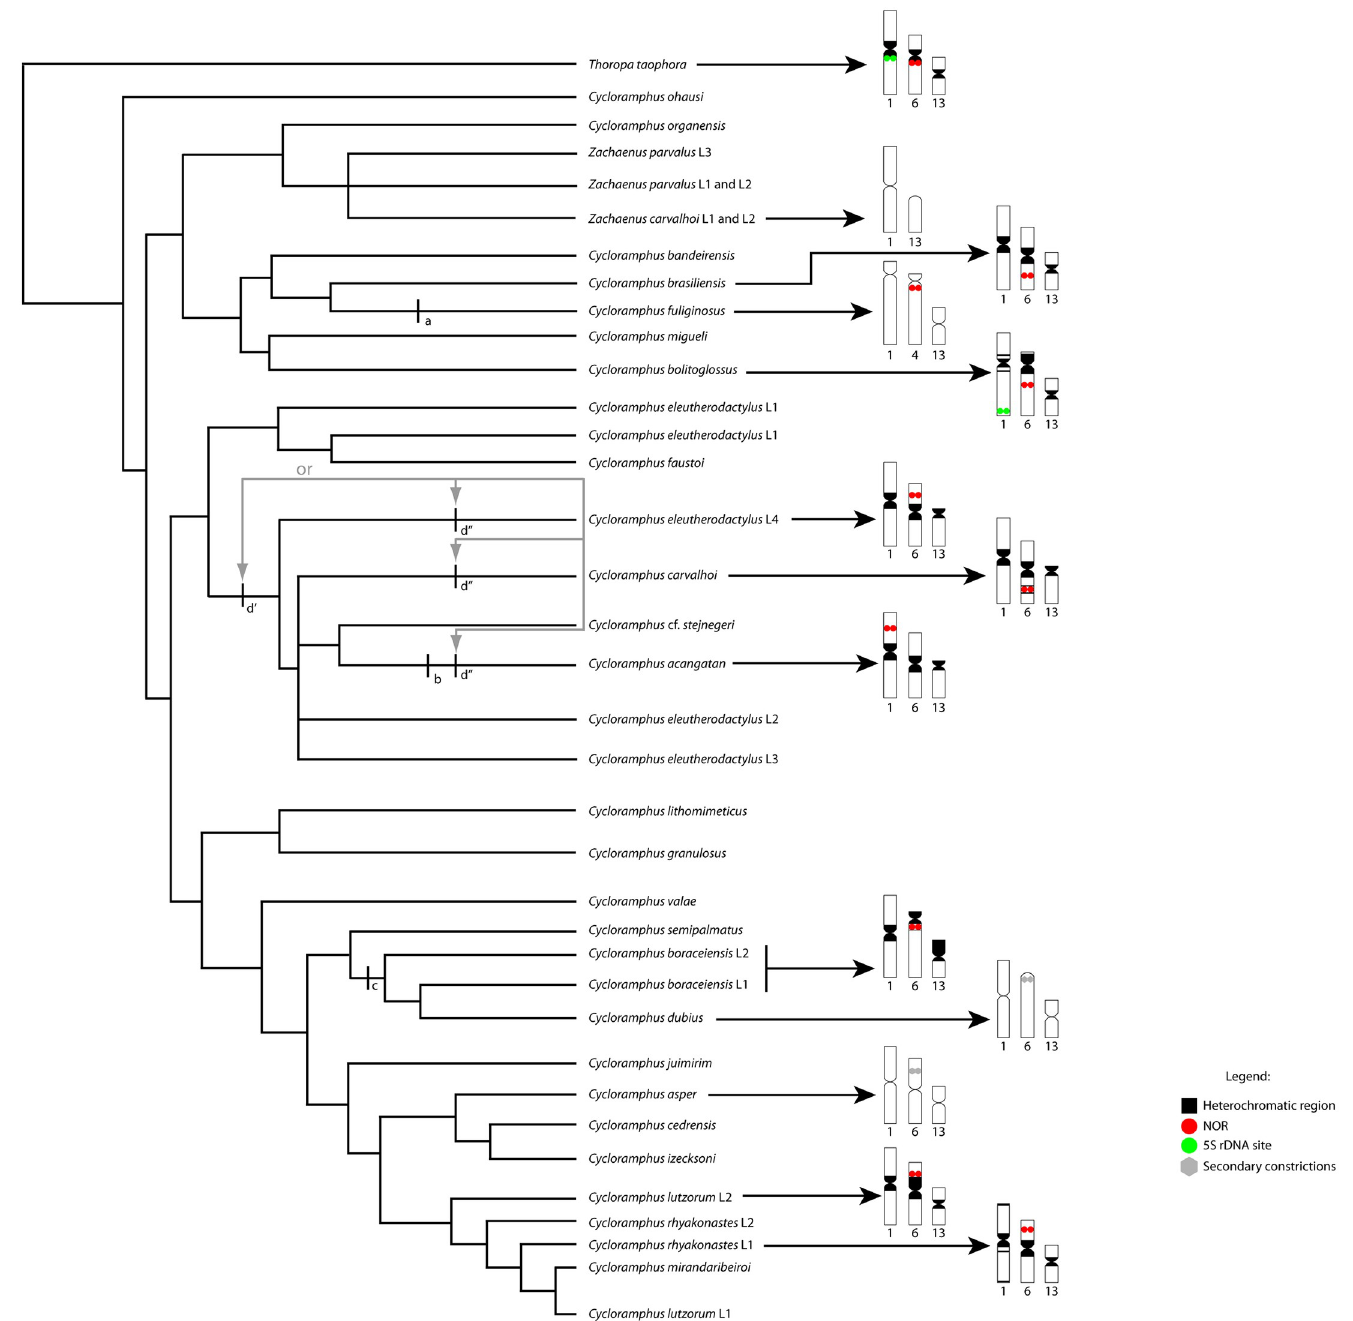
Fig 6. Phylogenetic reconstruction of the genus Cycloramphus . The hypothesis of the evolutionary chromosomal changes in the Cycloramphus and Zachaenus species, as inferred from the available cytogenetic data [5–8, 53] in the phylogeny of the genus presented by de Sa´ et al. [9]. Events of character transformation are indicated: (a) centromere repositioning in chromosome pair 1 of C . fuliginosus ; (b) repositioning of the NOR from pair 6 to pair 1 in C . acangatan ; (c) pericentromeric inversion in pair 6 of the common ancestor of the C . boraceiensis linages and C . dubius and (d’ or d”) a centromere repositioning in the chromosome 13 in the common ancestor of C . eleutherodactylus lineages L2, L3 and L4, C . carvalhoi , C . stejnegeri and C . acangatan , or independent repositioning in the lineages that gave rise to C . eleutherodactylus L4, C . carvalhoi and C . acangatan . The d’ and d” events are equally parsimonious hypothesis (indicated by grey arrows) given the available cytogenetic data for the genus Cycloramphus . Red circles indicate the NORs positions, Gray circles indicate the presence of secondary constrictions, and black regions indicate heterochromatin areas of the chromosomes.